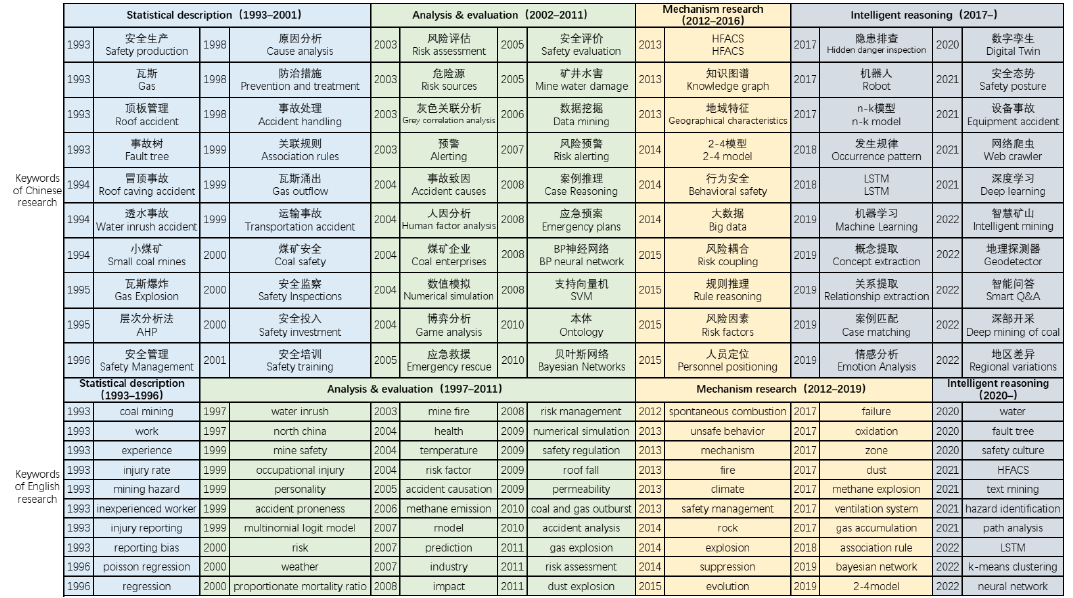
Figure 8. The evolution of keywords in English and Chinese studies.